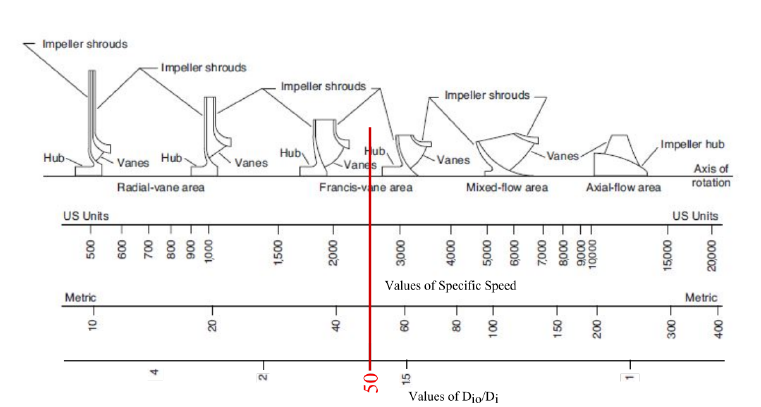
Figure 8. The choice of the impeller type as a function of the specific